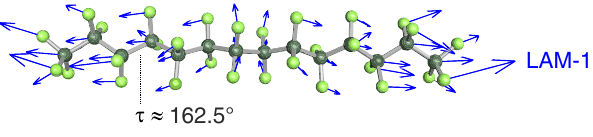
Figure 1. Minimum energy structure of C 14 F 30 on the B3LYP-D3/ def2-TZVP level. All CC torsion angles ( τ ) are close to 163°, sim- ilar to the 13/6 helix in the solid [10]. Blue arrows indicate the calculated LAM-1 normal